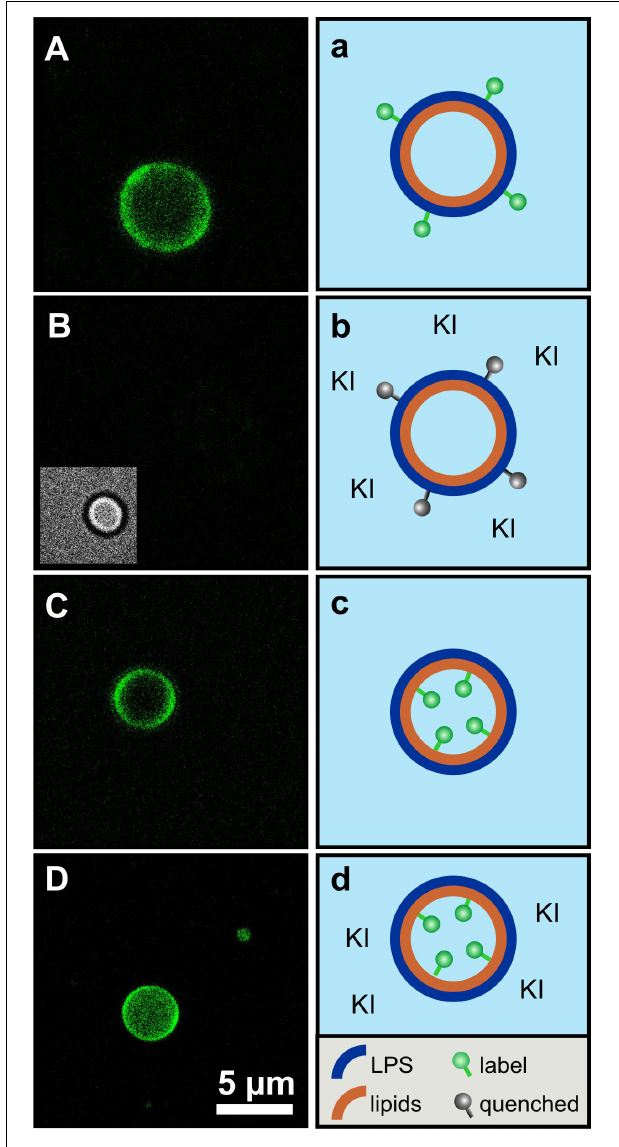
FIGURE 4 | The asymmetry of giant unilamellar LPS R45/PL vesicles is confirmed by leaflet-specific fluorescence quenching with KI. (A,a) Asymmetric vesicles with LPS R45 in the outer leaflet and PL (PE:PG:CL; 81:17:2; w/w/w) in the inner leaflet; 5% (w/w) of the LPS R45 molecules in the outer leaflet were fluorescent FITC-LPS R45; (B,b) Quenched fluorescence of the vesicles after the addition of KI. The inlet shows the vesicle in phase contrast; (C,c) Asymmetric vesicles with LPS R45 in the outer leaflet and PL in the inner leaflet; 2% (w/w) of the PL molecules in the inner leaflet were fluorescent FITC-PE; (D,d) Vesicles after the addition of KI. The fluorophores in the inner leaflet were protected from quenching. Experiments were carried out at 25 ◦ C in 100 mM KCl, 5 mM MgCl 2 , 5 mM HEPES buffer at pH 7.0 using a Leica TCS SP3 confocal microscope. Final KI concentration was 0.83 M; Scale bar applies to all